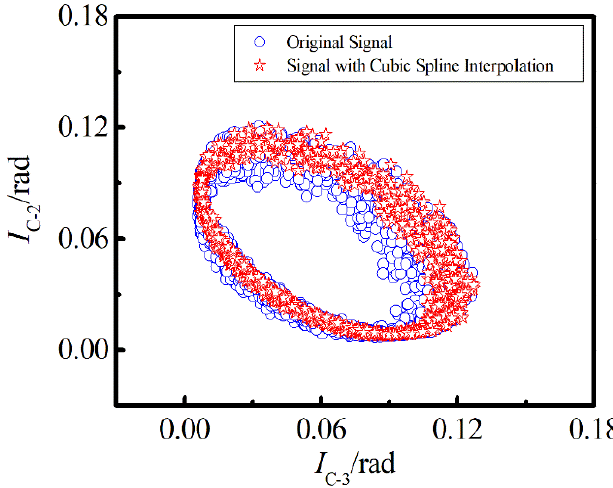
Figure 6. Lissajous figure of interference signals before and after interpolation.